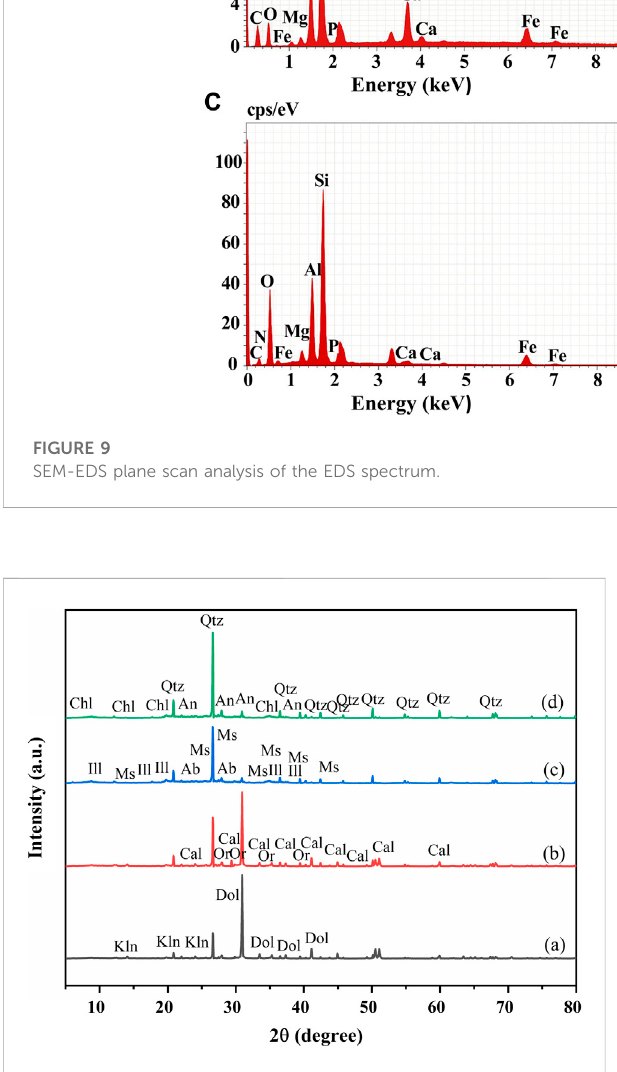
FIGURE 10 X-ray diffractogram patterns (Cu-K α radiation) and mineral change ofsoilaggregatesalongthesoilchronosequence (Cal, calcite; Chl, chlorite; Dol, dolomite; Ill, illite; Kln, kaolinite; Ms, muscovite; Or, orthoclase; Qtz, quartz; An, anorthite; Ab,